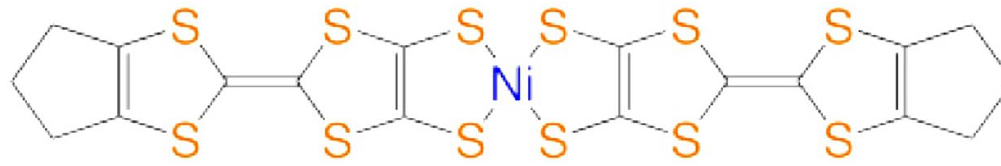
Figure 8. Schematic representation of the molecule, Ni (tmdt) component molecular